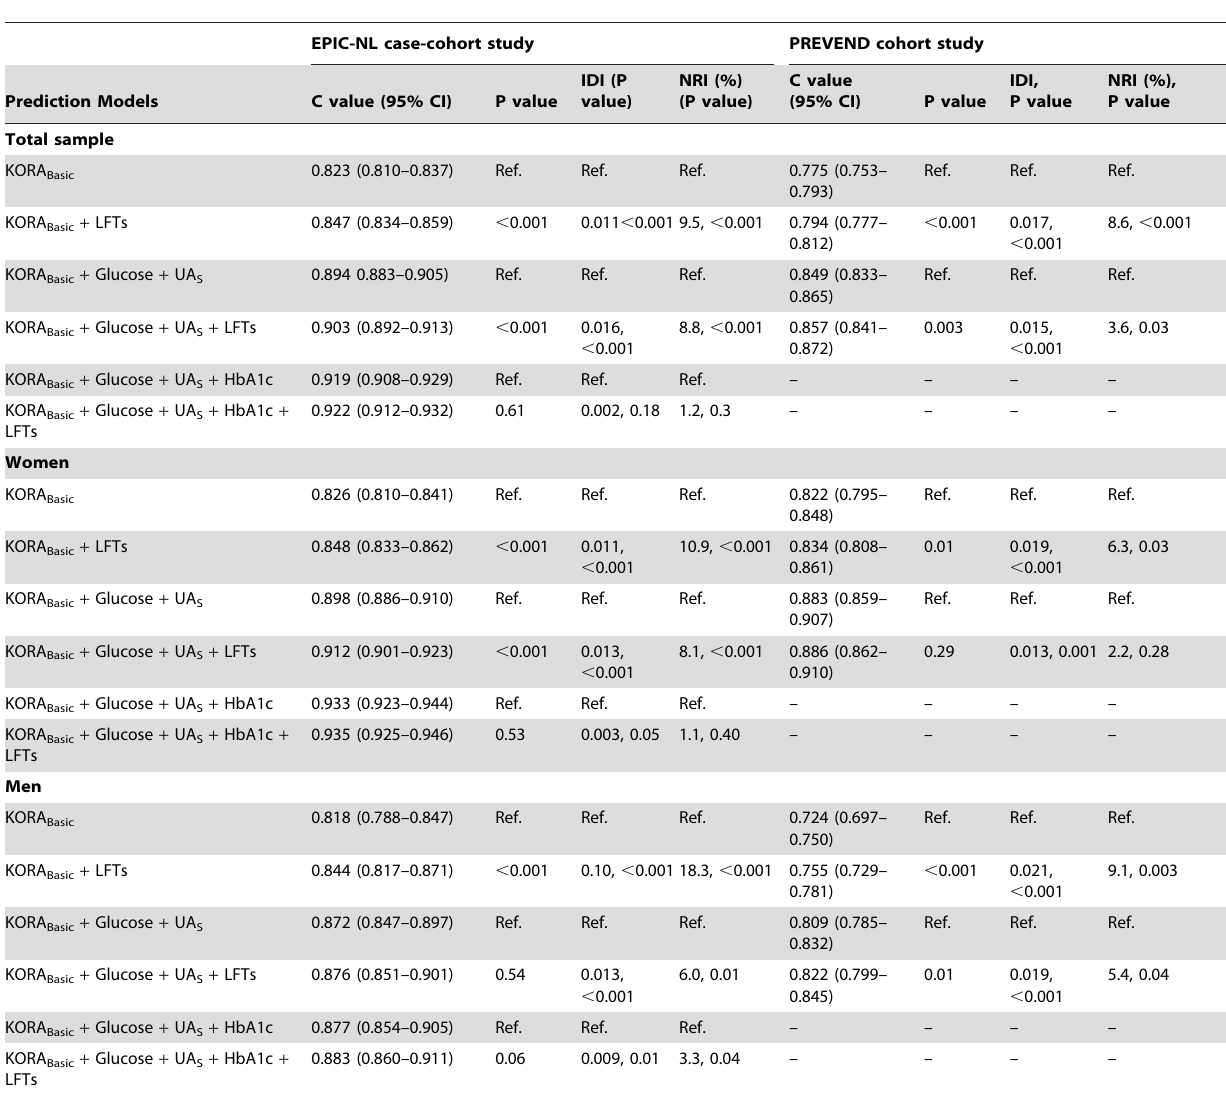
Table 3. Incremental predictive value of liver function tests for the risk of type 2